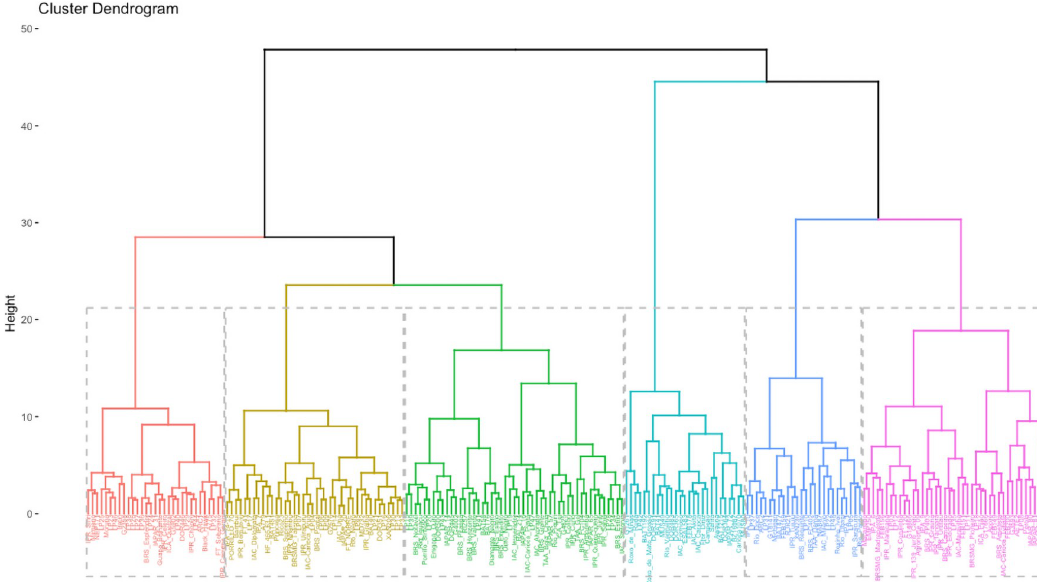
Fig 4. Ward’s hierarchical clustering analysis of 215 Mesoamerican common bean accessions. Analysis was performed using standardized Euclidean